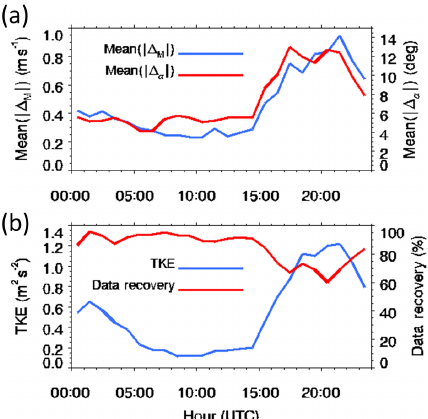
Figure 8. (a) Diurnal variation of the mean absolute wind speed difference (blue) and the mean absolute wind direction difference (red) between the CDL and the tower sonic anemometers for Trial 2. (b) Diurnal variation of the TKE (blue) and the data recovery (red). The CDL wind retrievals were quality controlled using a relative estimated precision threshold of